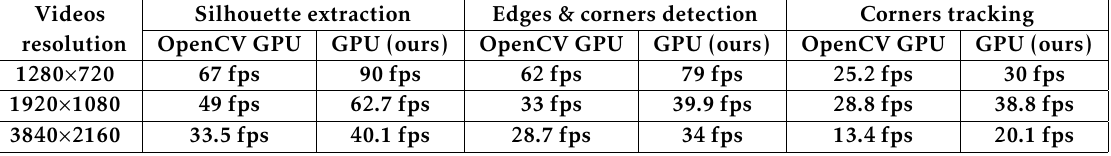
Table 3. Performance of silhouette extraction, corners detection and tracking on GPU: CPU Intel i5 and GPU GTX